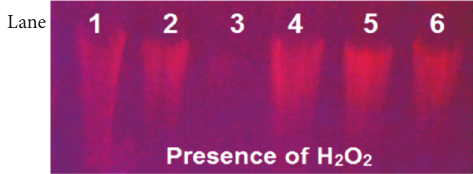
Figure 6: Agarose gel diagram showing cleavage of CT-DNA by ligand HL and complexes 1 – 4 at RT. Lane 1: DNA control + H 2 O 2 ; Lane 2: DNA + HL + H 2 O 2 ; Lane 3: DNA + 1 + H 2 O 2 ; Lane 4: DNA